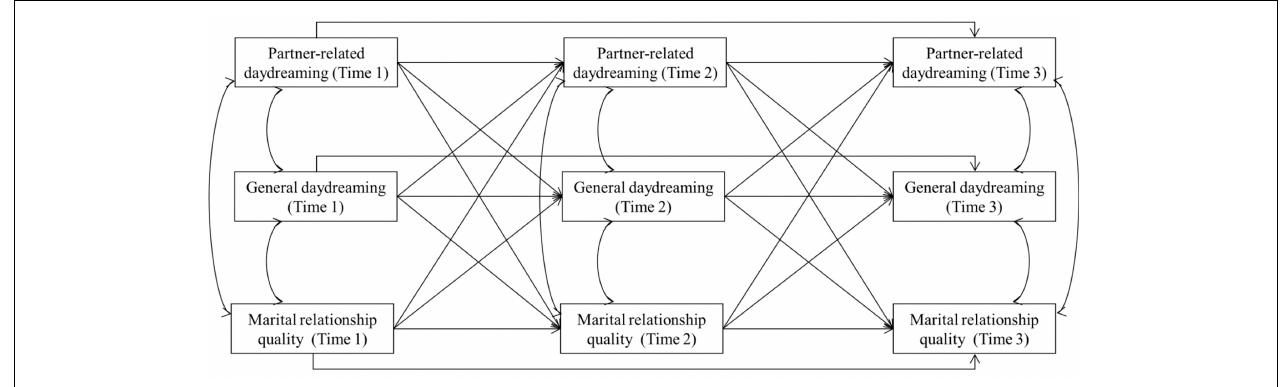
FIGURE 1 | Cross-lagged model. Control variables (gender and marital duration) are not displayed for clarity of presentation. Marital relationship quality is indicated by any subscale of the Investment Model Scale.